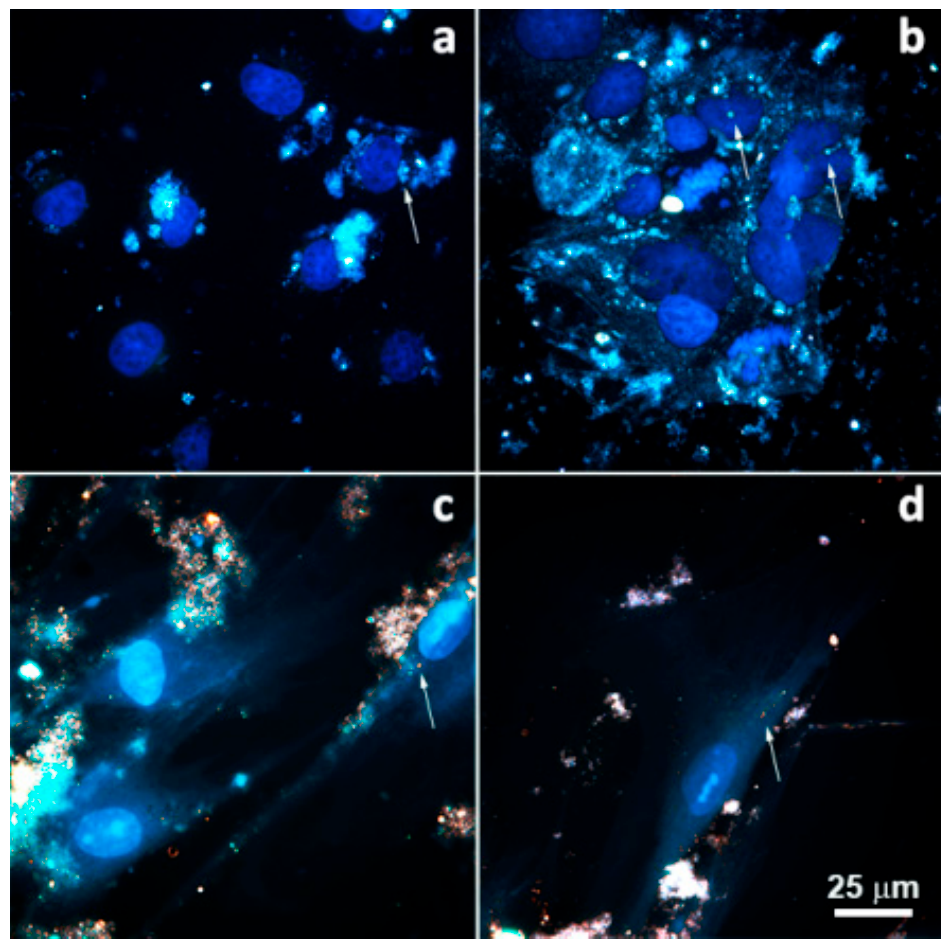
Figure 7. Dark-field images merged with fluorescence images of malignant (A549 ( a ), Caco-2 ( b )) and non-malignant (HSF ( c ), MSC ( d )) cells after 24 h incubation with halloysite nanotubes (nanotubes are indicated by arrows).